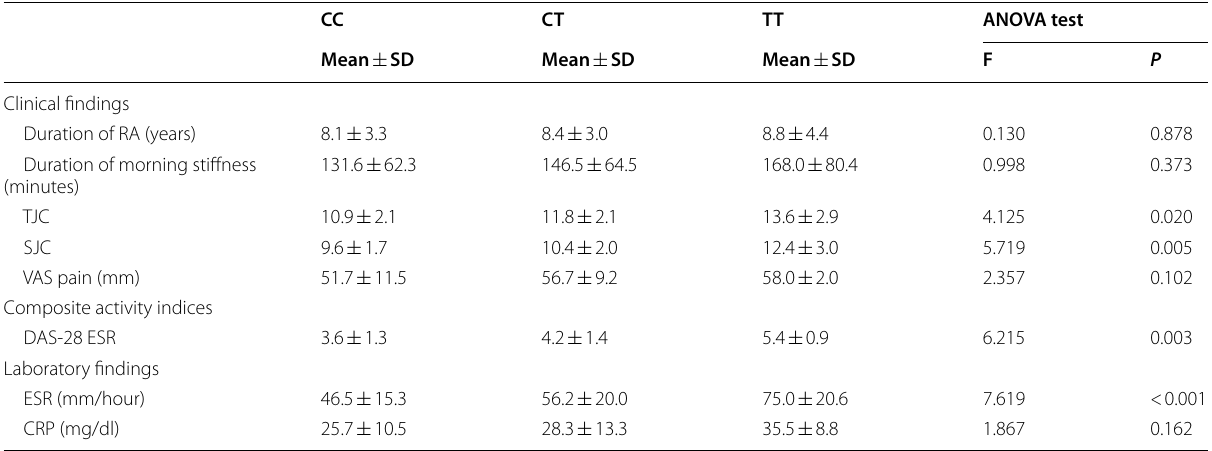
Level of significance at P